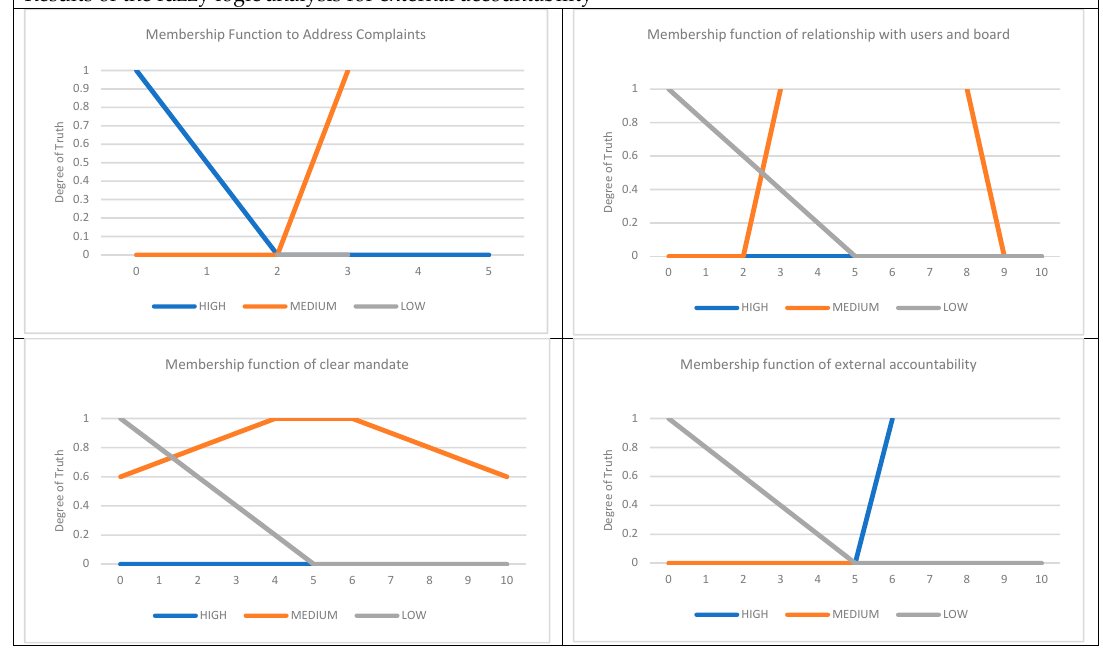
Figure 2. Application of the fuzzy logic analysis.